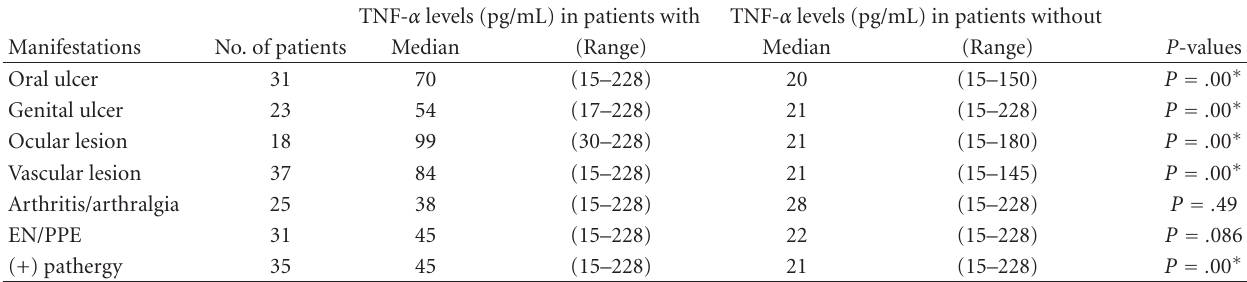
Table 4: The significance of the association of TNF- α with versus without individual clinical manifestations and pathergy reaction. TNF- α levels (pg/mL) in patients with